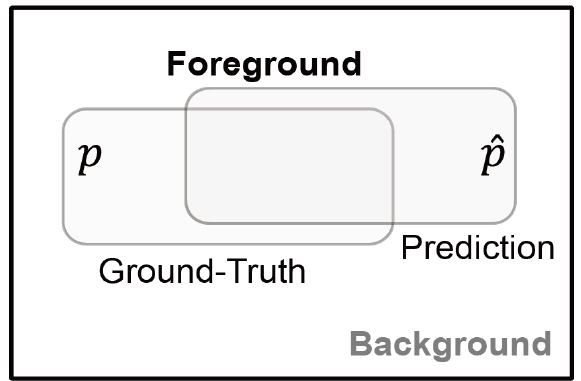
Figure 5. Parameters used for image